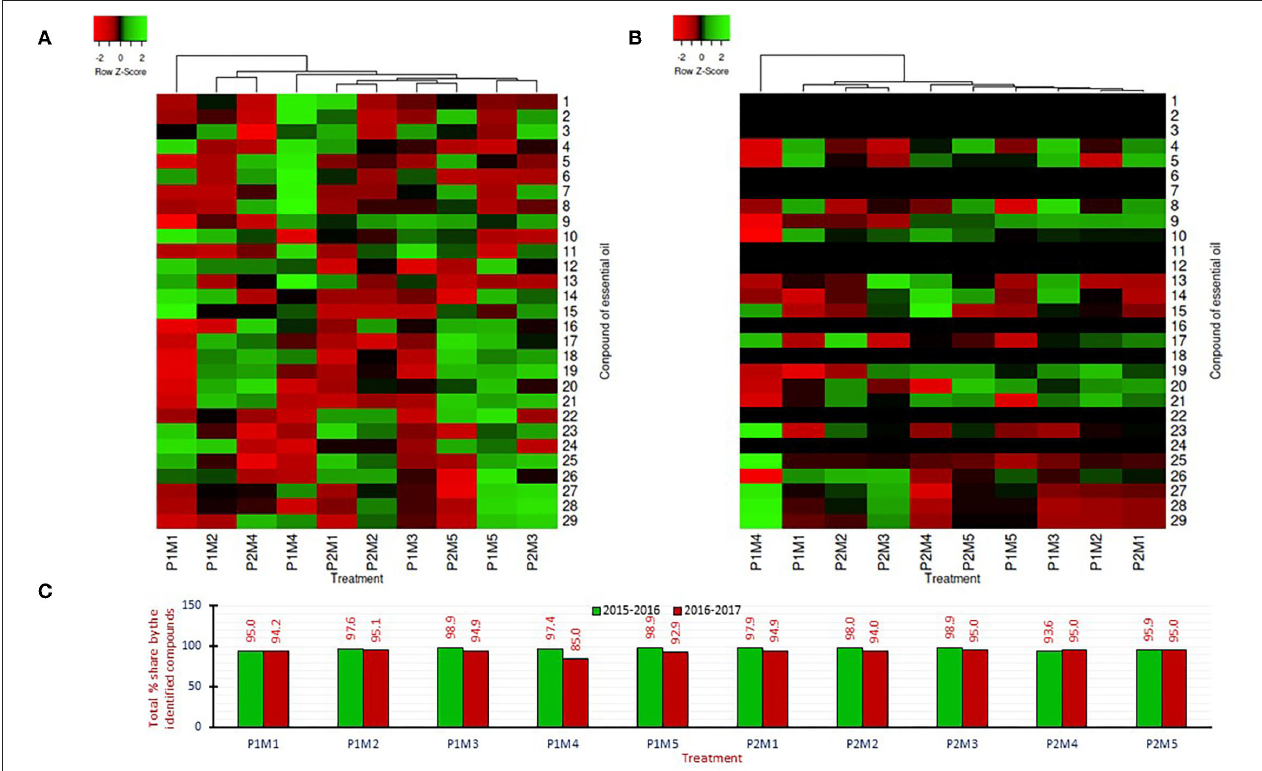
FIGURE 5 | Heatmaps illustrating the variation of components identified in the essential oil of damask rose under different treatment combinations for the growing seasons of 2015–2016 (A) and 2016–2017 (B) . The total percentage share by the identified compounds is presented in (C) . 1, α -Pinene; 2, β -Pinene; 3, β -Myrcene; 4, Linalool; 5, cis-Rose oxide; 6, Phenyl ethyl alcohol; 7, e-Rose oxide; 8, 4-Terpineol; 9, β -Citronellol + Nerol; 10, Geraniol; 11, e-citral; 12, Citronelleyl acetate;13, Eugenol; 14, Geranyl acetate; 15, β -Elemene; 16, Methyl eugenol; 17, E-caryophyllene; 18, α -Guaiene; 19, α -Humulene; 20, Germacrene D; 21, Pentadecane; 22, Heptadecane; 23, Farnesol; 24, Octadecane; 25, Nonadecene; 26, Nonadecane; 27, Eicosane; 28, Heneicosane; 29, Tricosane. P1, Ground-level pruning; P2, Ground level-pruning + top pruning; M1, Ground-level pruning during June; M2, Ground-level pruning during July; M3, Ground-level pruning during August; M4, Ground-level pruning during September; M5, Ground-level pruning during